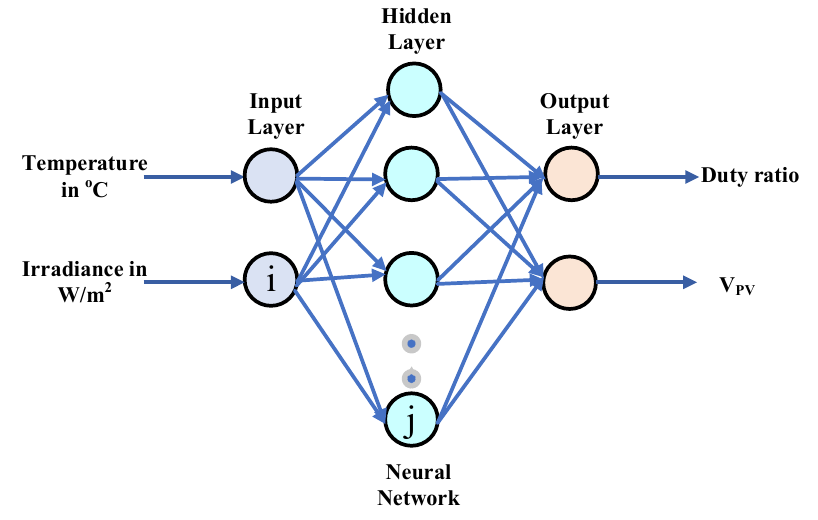
Figure 11. Three-layer Figure 11. Three ‐ layer ANN.